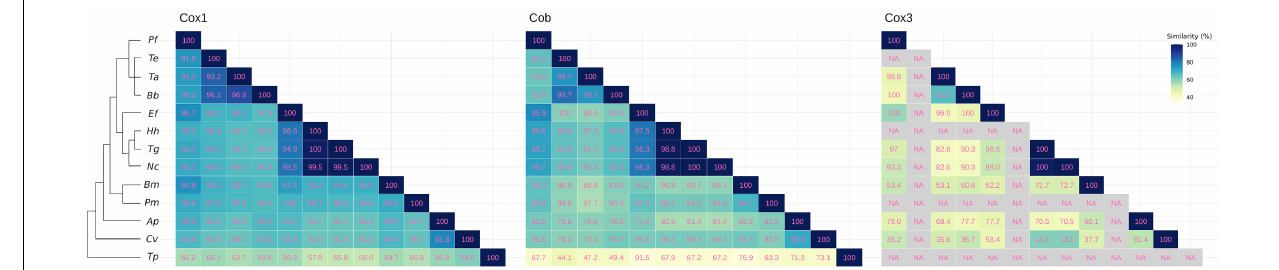
FIGURE 2 | Protein sequence conservation of the three retained mitochondrial genes within Apicomplexa and evolutionarily related organisms. Heatmaps show similarity in local blastp pairwise protein alignments. Percentages of positive-scoring matches for Cox1, Cob, and Cox3, are shown according to the color scale, as indicated. Percentages of alignment coverage (alignment length normalized by the average protein length) are indicated as numbers. Abbreviated labels and NCBI accession identifiers for protein sequences used for Cox1, Cob, and Cox3, are as follows: Pf: P. falciparum; YP_009480320.1, YP_009480321.1, AAC06268.1; Te: T. equi, XP_025033546.1, XP_025033545.1, NA; Ta: T. annulata, XP_039113697.1, XP_039113699.1, XP_039113698.1; Bb: B. bovis , YP_001504106.1, YP_001504108.1, YP_001504107.1; Ef: E. fuonis, NC_039745.1, NC_039745, YP_009531492.1; Hh: H. heydorni, AFQ31671.1, AFQ31670.1, NA; Tg: T. gondii, AFQ31675.1, XP_018634734.1, AFQ31675.1; Nc: N. caninum , AFQ31673.1, QLF97291.1, QLF97290.1; Bm: B. minutum, BAS21362.1, BAS21364.1, BAS21363.1; Pm: P. marinus , ADZ98701.1, ADZ98702.1, NA; Ap: A. peruviana, AHA41651.1, AHA41650.1, AHA41680.1; Cv: C. vietnamica , AHA41634.1, AHA41615.1, AHA41635.1; Tp: T. pyriformis, AAA32102.2, AAD41943.1, NA. NA corresponds to missing or unavailable data. To the left, tree topology corresponds to that used for Figure 1